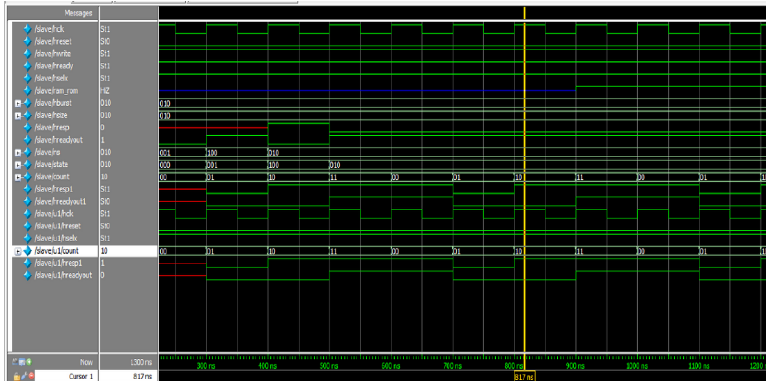
Fig. 9. Simulation waveform of Burst mode operation in AHB master